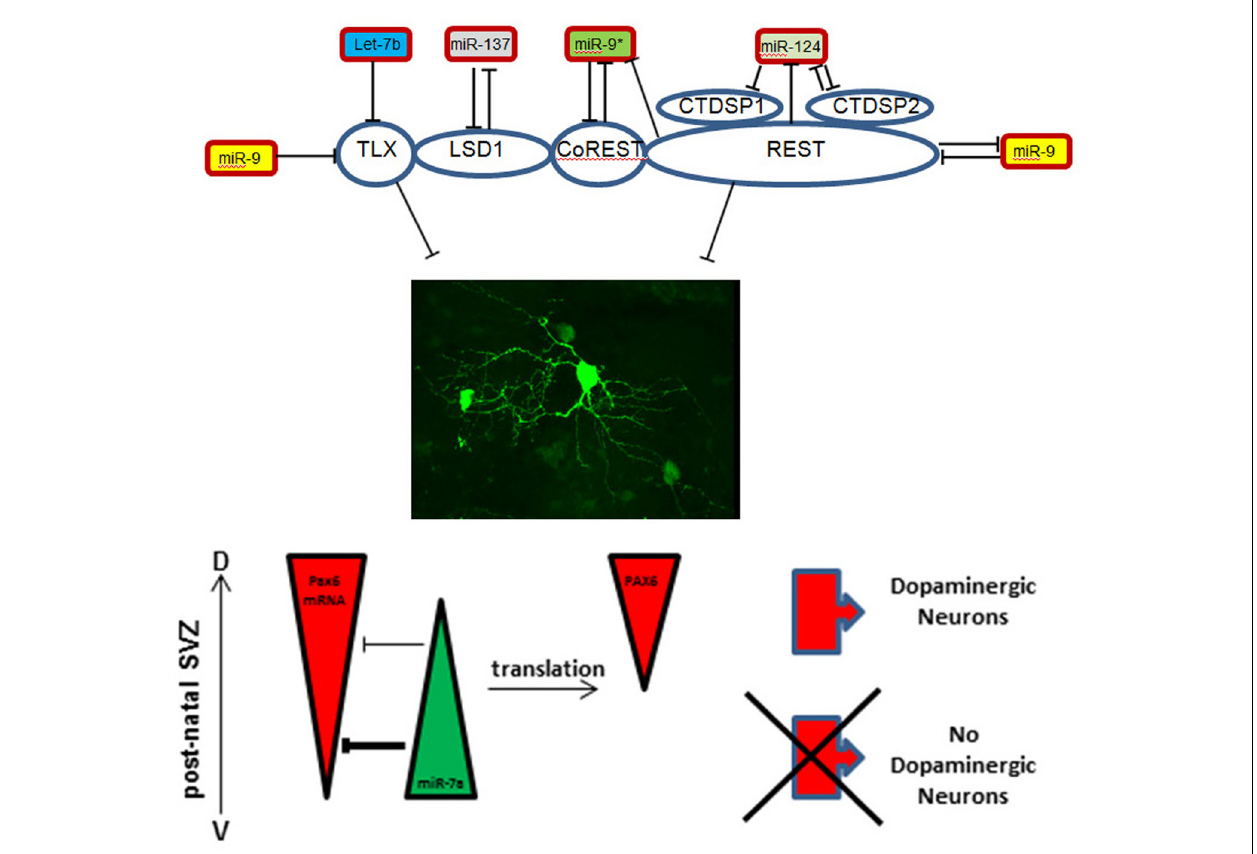
FIGURE 1 | Schematic representation of microRNA-target interactions in the control of maintenance versus differentiation in the neural stem cell